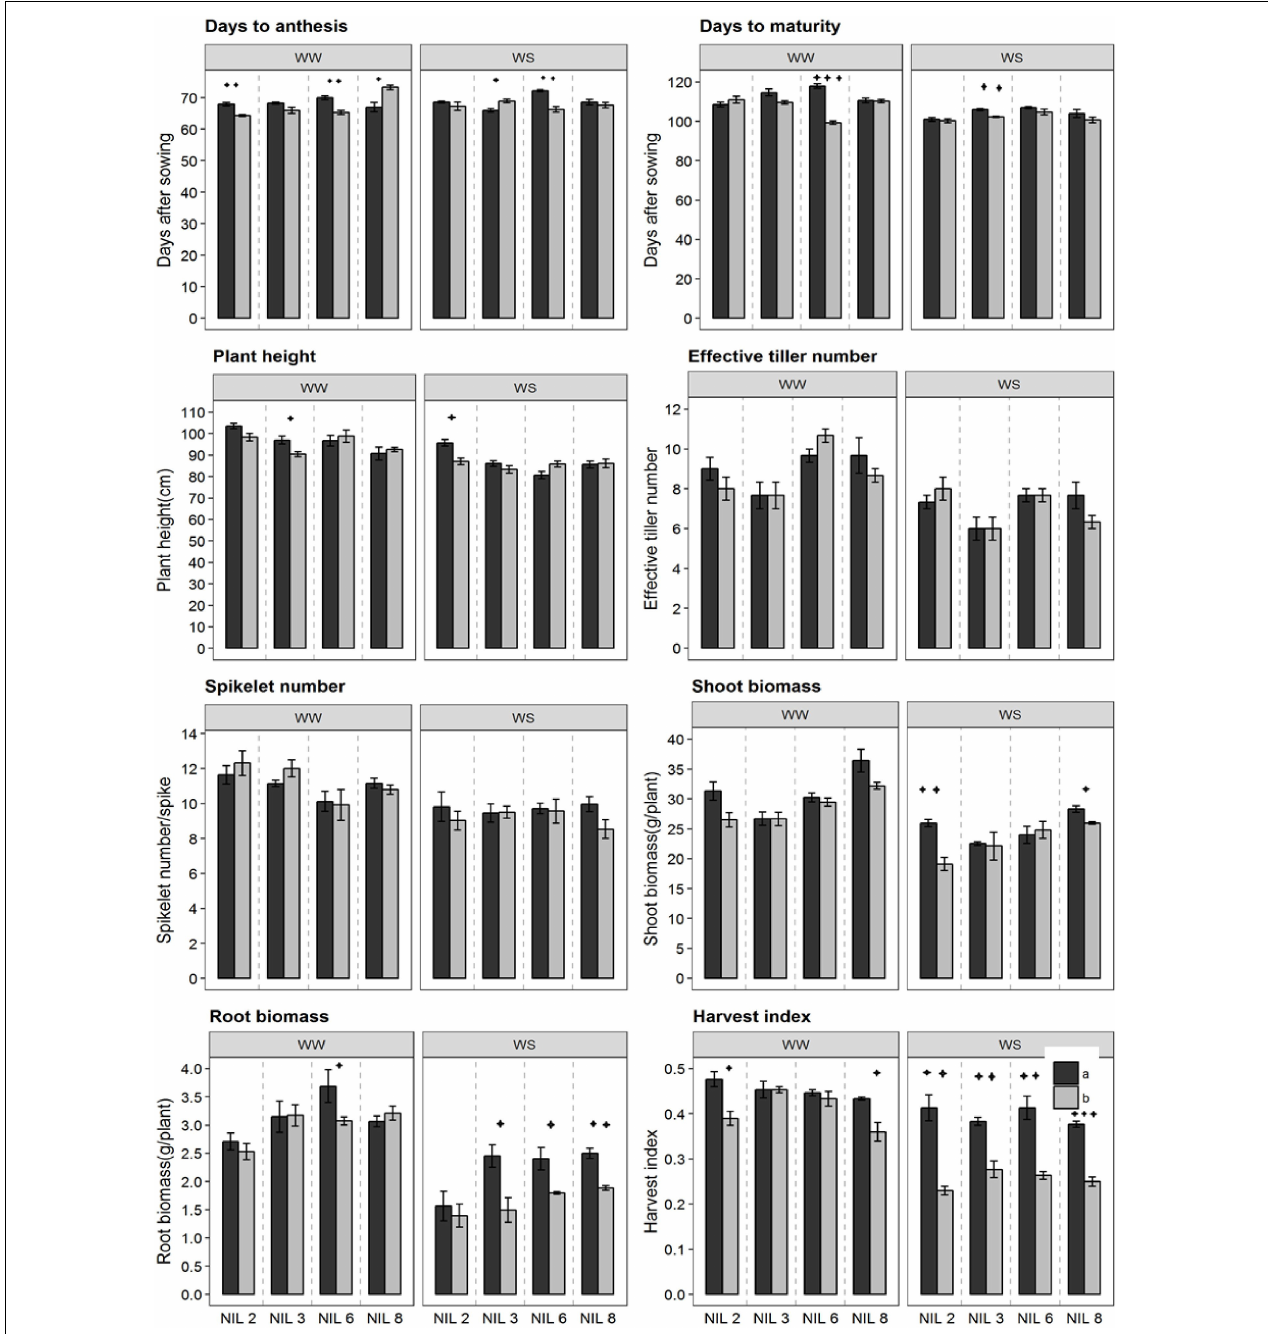
FIGURE 3 | Different phenological traits of the confirmed NIL pairs. qDSI.4B1-2, qDSI.4B1-3, qDSI.4B1-6, and qDSI.4B1-8 are denoted as NIL 2, NIL 3, NIL 6, and NIL 8, respectively. a = NIL with C306 background (+NIL), b = NIL with Dharwar Dry background (–NIL), ∗ = significant at P ≤ 0.05, ∗∗ = significant at P ≤ 0.01, ∗∗∗ = significant at P ≤